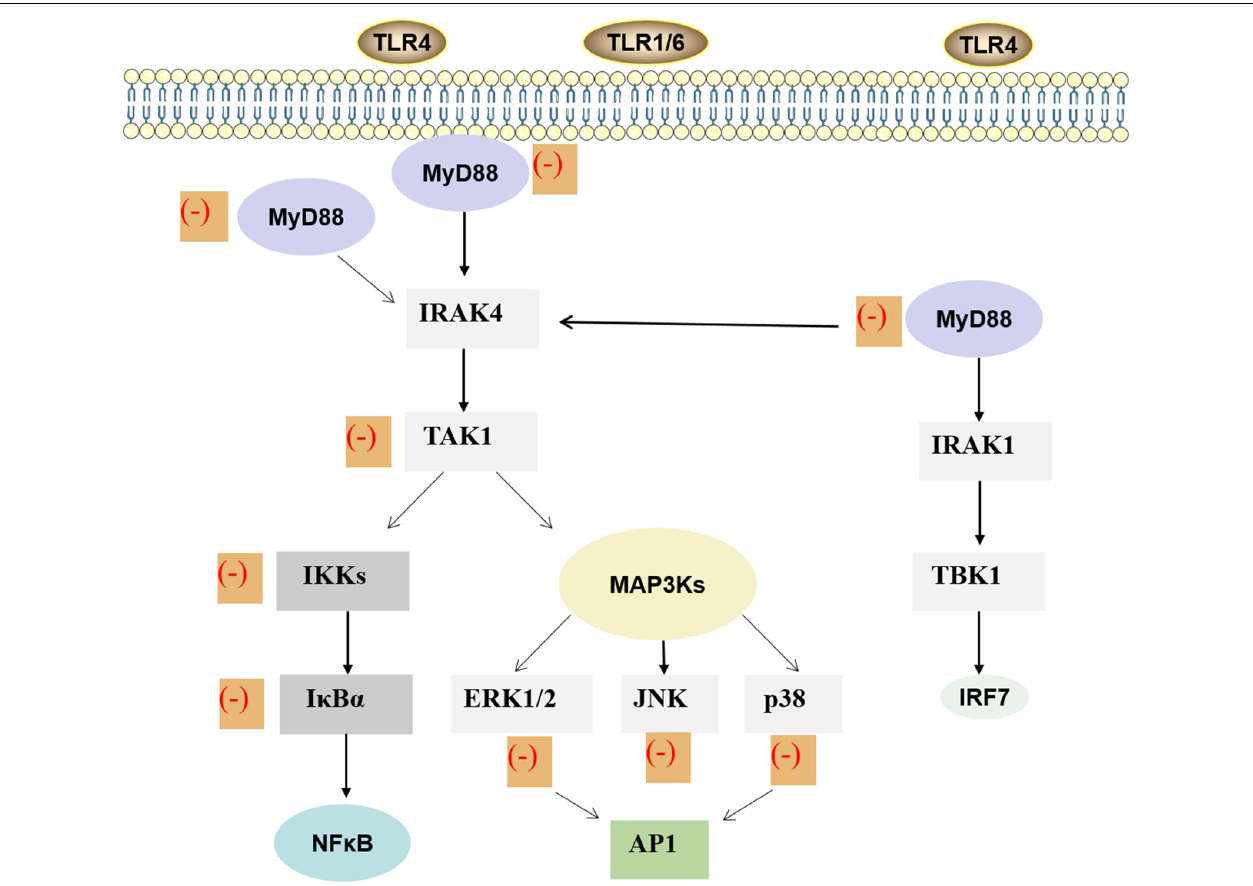
FIGURE 3 | MAPK and NF- κ B signaling pathway of ginkgolides in the regulation of IIR. Lipopolysaccharide stimulates the dimerization of TLR4 and activates the conserved MAPK tertiary kinase cascade through MyD88, interleukin-1 receptor-associated kinase, which leads to the activation of transcription factors. Finally, it promotes the expression of inflammatory factors in target cells, thus participating in the inflammatory reaction process induced by lipopolysaccharide. As shown in the figure, ginkgolides have effects on MAPK and TLRs/MyD88/NF- κ B signaling transduction pathway. It can down-regulate MyD88, transforming growth factor- β -activated kinase-1, I κ B kinases, I κ B α , extracellular signal-regulated protein kinase 1/2, extracellular signal-regulated JNK, and p38, ultimately reducing inflammation. MAPK, mitogen-activated protein kinase; NF- κ B, nuclear factor-kappa B; IIR, inflammatory immune response; MyD88, myeloid differentiation primary response 88; TLR, toll-like receptor.TLR, toll-like receptor; MyD88, myeloid differentiation primary response 88; IRAK, interleukin-1 receptor-associated kinase; TAK1, transforming growth factor- β -activated kinase-1; IKK, I κ B kinases; MAP3K, mitogen-activated protein kinase kinase kinase; ERK, extracellular signal-regulated protein-1; JNK, c-Jun amino-terminal kinase; NF- κ B, nuclear factor- κ B; AP1, activator protein-1; TBK1, TANK-binding kinase 1; IRF, interferon regulatory factor; IIR, inflammatory immune